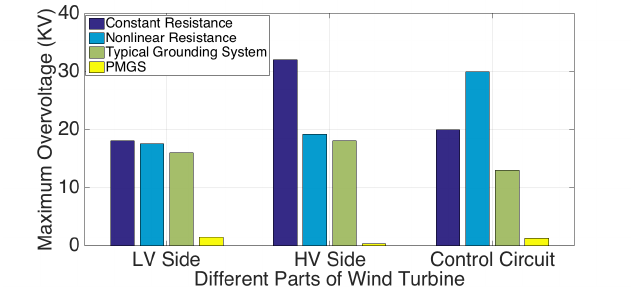
Figure 4. Comparison of different types of grounding schemes.